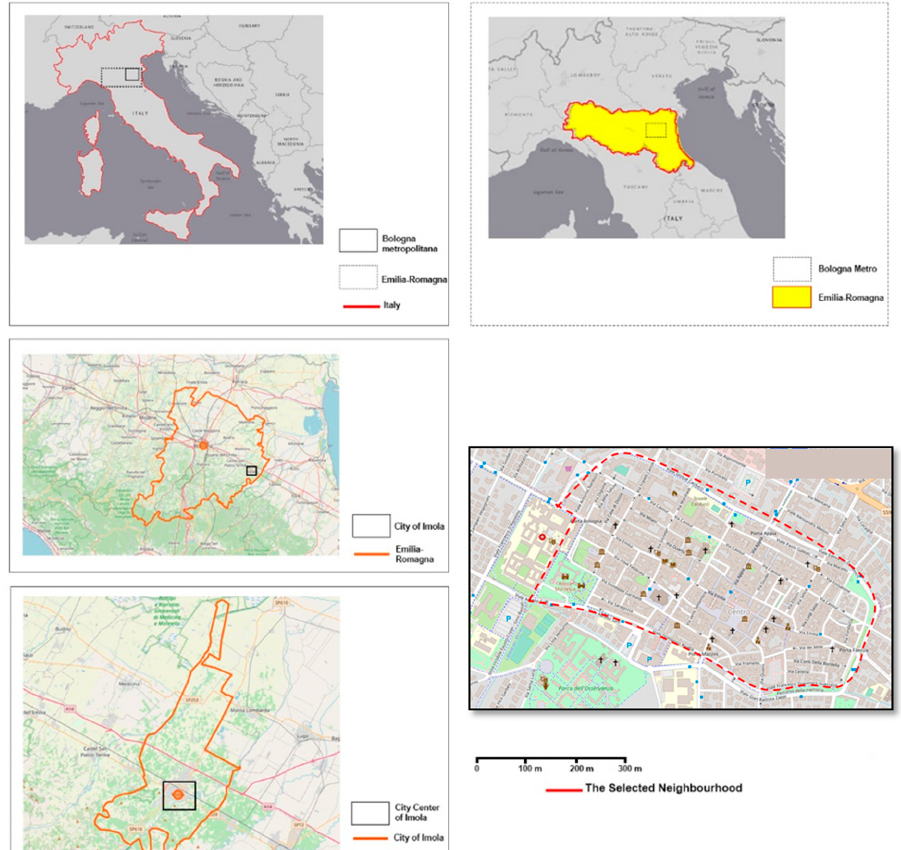
Figure 4. Aerial view of the study area in Imola, Italy.